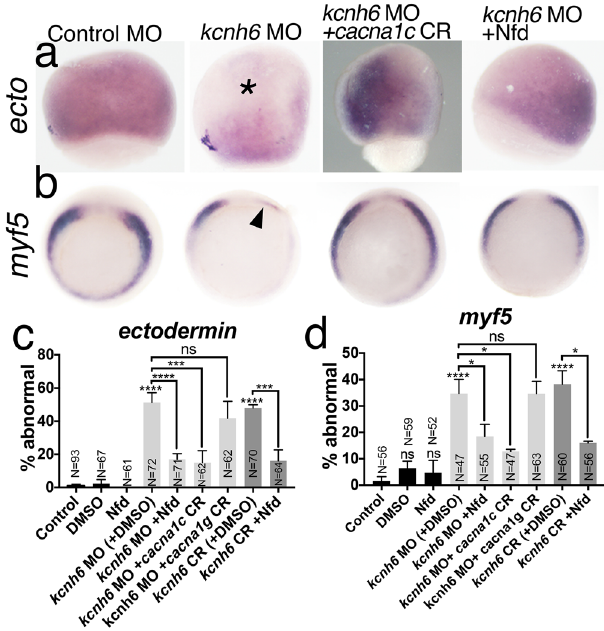
Fig. 5 | The roleofVGCCsingermlayer differentiation. a WMISHfor ectodermin ; lateral views with the animal pole to the top; asterisk marks the animal pole with loss of ectodermin expression; embryos with absent expression are quanti fi ed in c ; CRCRISPR,Nfdnifedipine. b WMISHfor myf5: vegetalviewswithdorsaltothetop; arrowhead marks loss of expression; embryos with abnormal expression are quanti fi edin d . c , d Percentagesofembryoswithabnormal ectodermin ( c )and myf5 ( d ) expression. Graphs depict mean±SEM; p -values are in c : ( kcnh6 MO+DMSO vs DMSO)=2.88e-006, ( kcnh6 MO+Nfd vs kcnh6 MO+DMSO)=4.59e-002, ( kcnh6 MO + cacna1c CR vs kcnh6 MO)=1.53e-002, ( kcnh6 MO+ cacna1g CR vs kcnh6 MO)>9.99 e-001 (ns), ( kcnh6 CR+DMSO vs DMSO)=3.50e-007, ( kcnh6 CR+Nfd vs kcnh6 CR +DMSO)=1.20e-002; in d : p -values are ( kcnh6 MO+DMSO vs DMSO)=4.07e-015, ( kcnh6 MO+Nfd vs kcnh6 MO+DMSO)=8.92e-005, ( kcnh6 MO+ cacna1c CR vs kcnh6 MO)=4.78e-005, ( kcnh6 MO+ cacna1g CR vs kcnh6 MO)=2.24e-001 (ns), ( kcnh6 CR+DMSO)=2.04e-014, ( kcnh6 CR+Nfd)=1.45e-003; two-sided Fisher ’ s exacttest; totalembryo numbers (N)inthe graphs are from atleast 2independent experiments; Key for asterisks: * p ≤ 0.05, *** p ≤ 0.001, **** p ≤ 0.0001, ns non- signi fi cant for p >0.05. Source data are provided as a Source Data fi